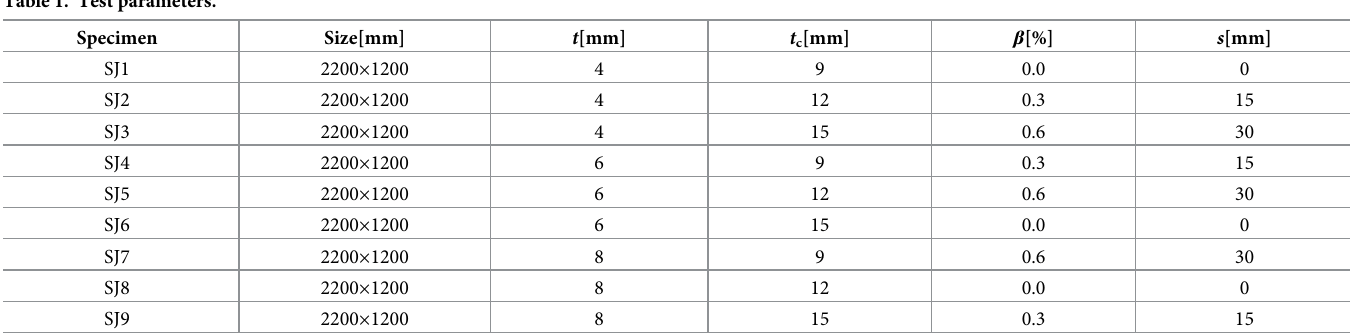
Table 1. Test parameters.